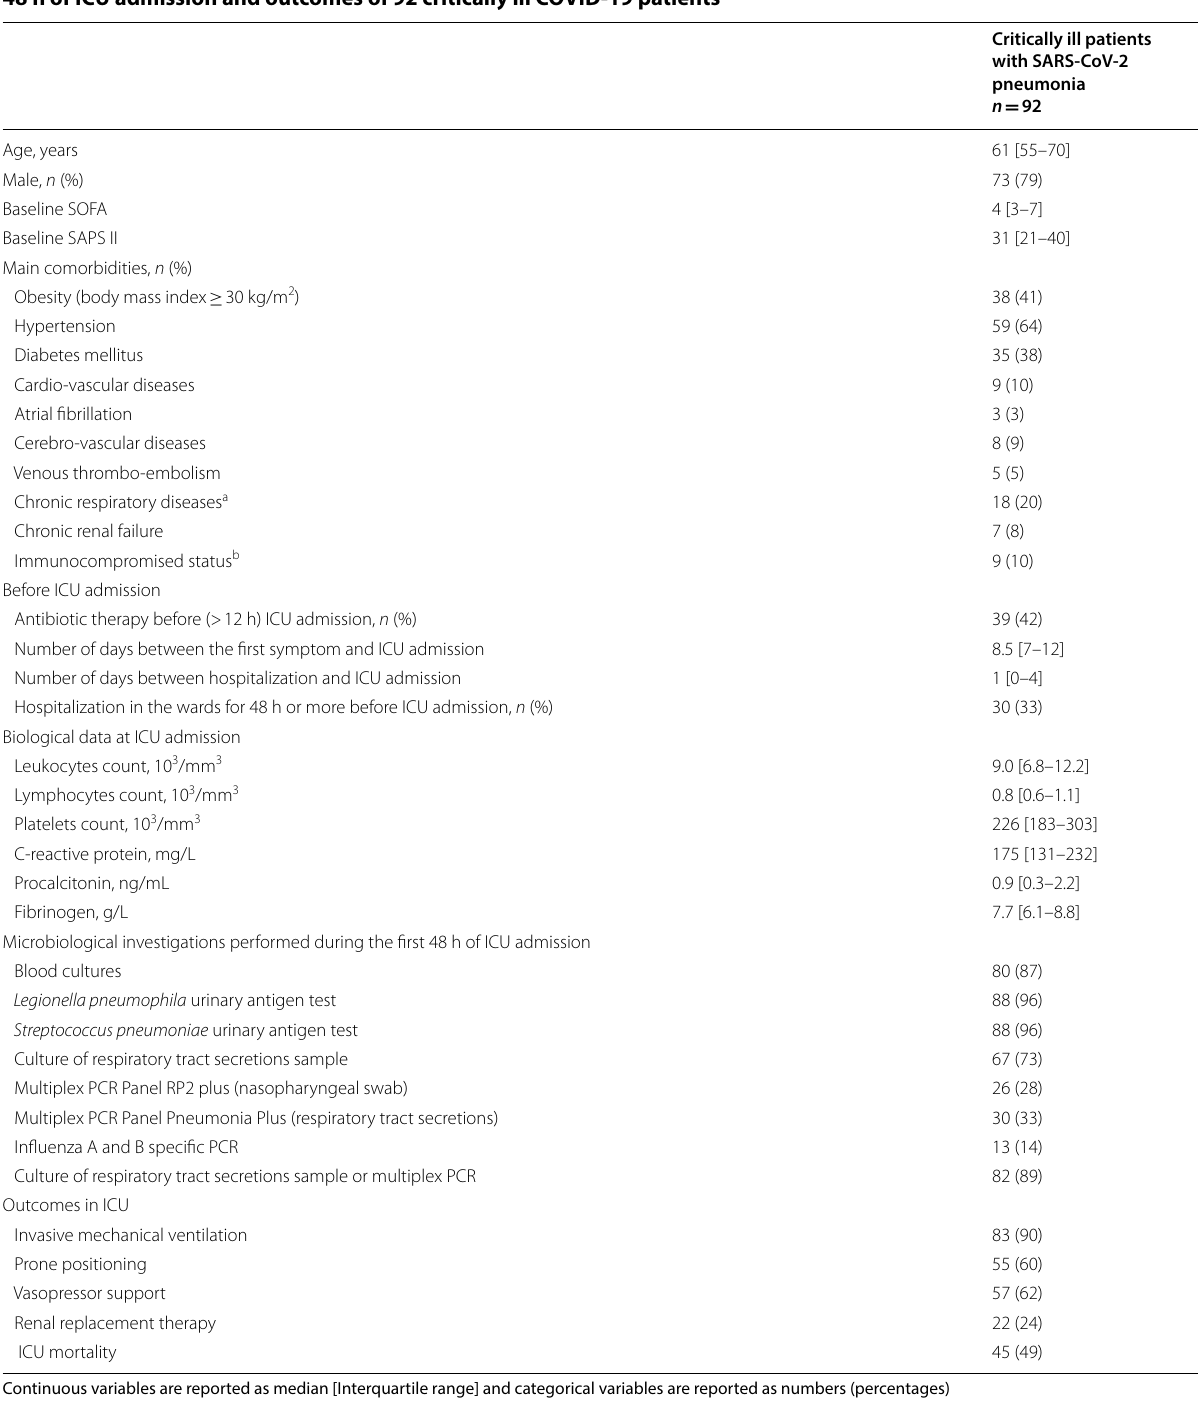
Table 1 Main characteristics, comorbidities, biological data, microbiological investigations performed within the